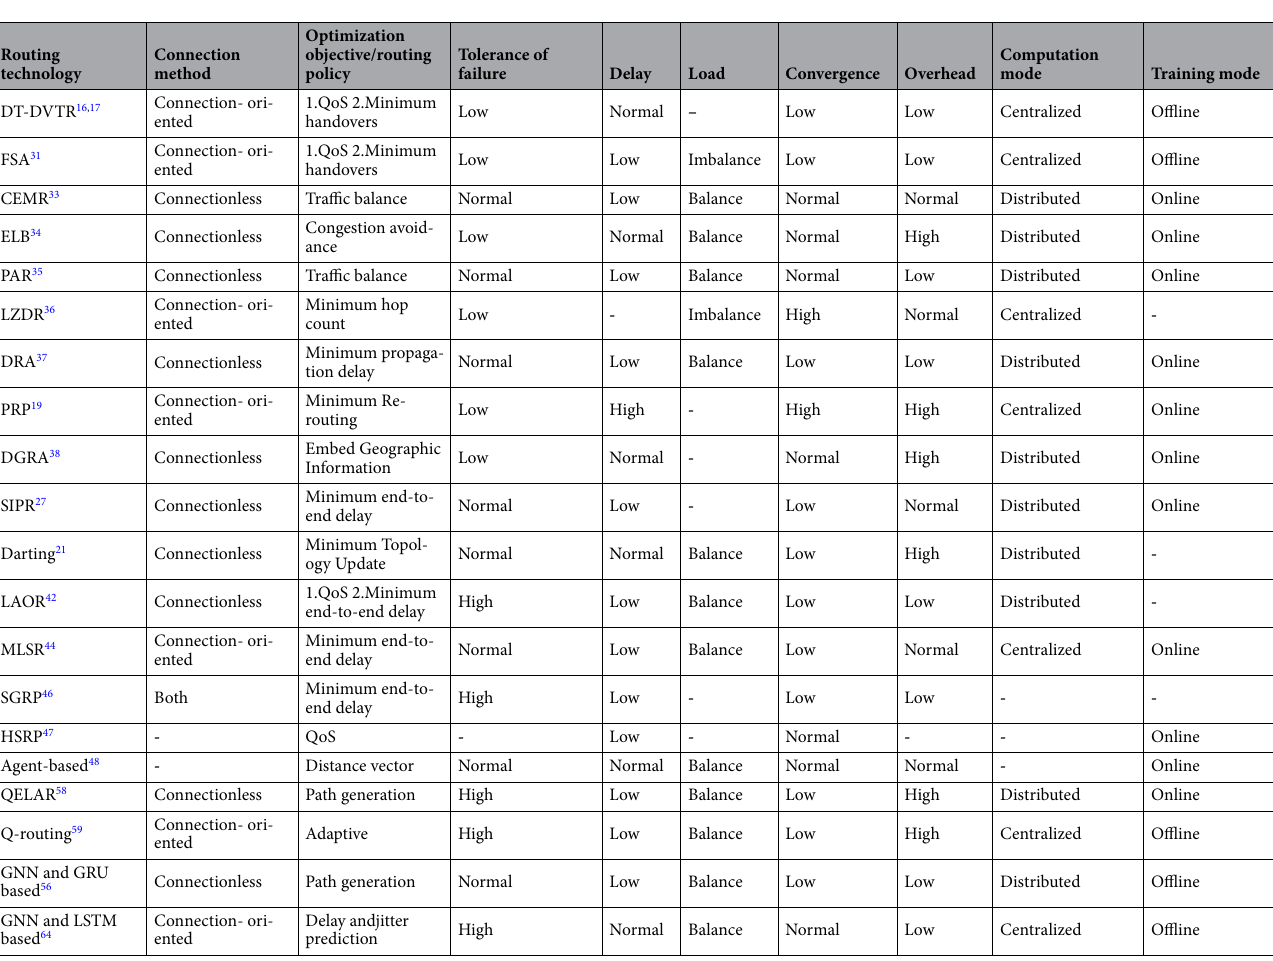
Table 3. Comparison of routing technologies in